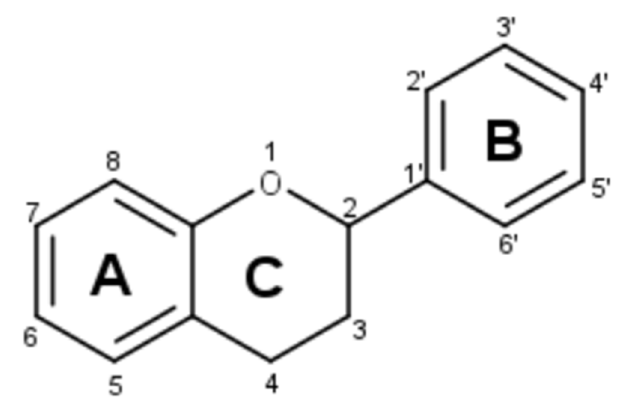
Figure 1. Flavonoid structure.